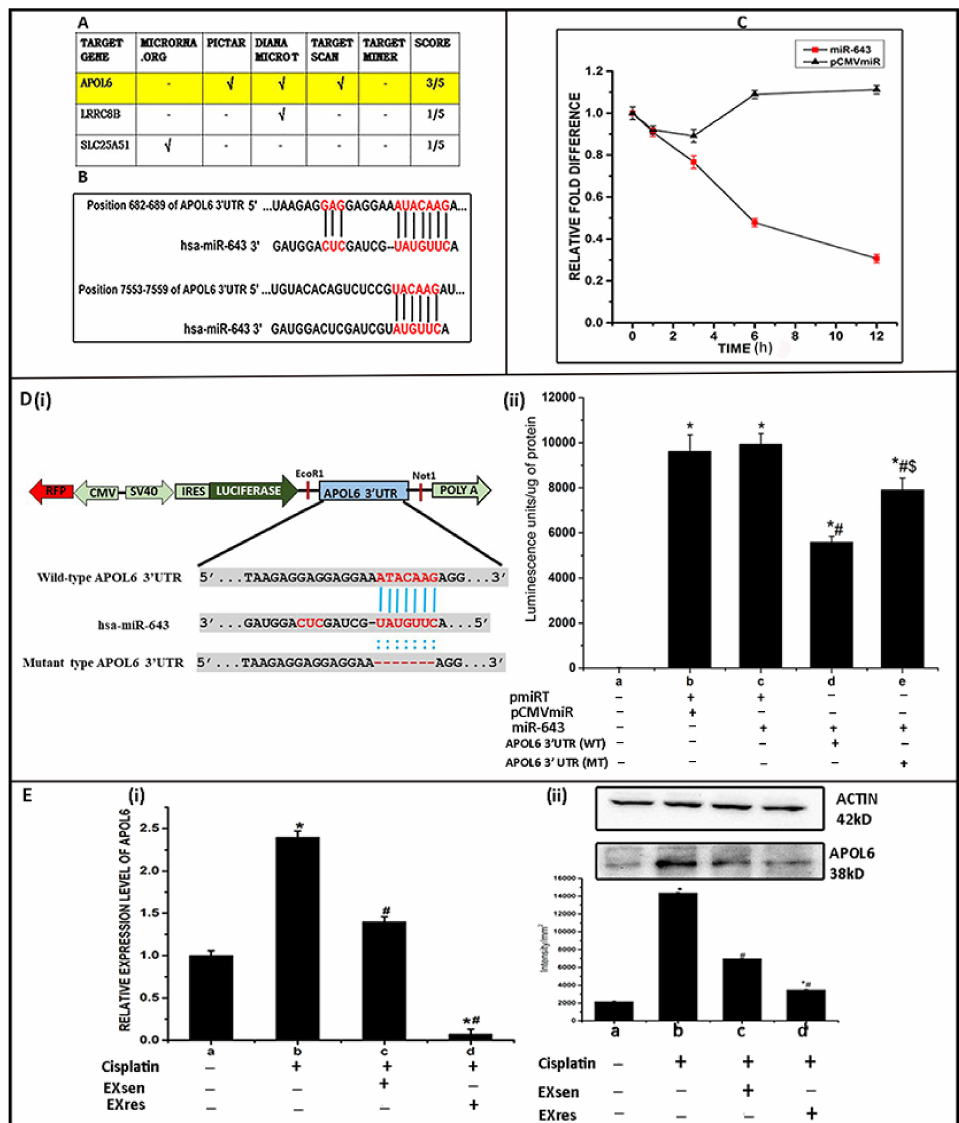
Figure 5. EXres-mediated alteration in cisplatin resistance involves APOL6. ( A ) Target prediction analysis of miR-643. Target prediction analysis of miR-643 was carried out using five different web-based tools such as microrna.org, Pictar, Diana micro T, TargetScan, and Target miner followed by scoring. ( B ) 3 (cid:48) UTR analysis of APOL6 was carried out using a web-based tool TargetScan showing the sequence alignments between miR-643 and 3 (cid:48) UTR of APOL6. ( C ) APOL6 mRNA stability assay. miR-643 overexpressing cells were treated with actinomycin at a concentration of 6 µ g for different time intervals such as 0, 1, 3, 6, and 12 h followed by RNA isolation from these cells and RT-PCR analysis of APOL6 mRNA. The term relative fold difference refers to relative expression level of APOL6 mRNA in the presence or absence of miR-643. ( D ) Luciferase reporter assay. The wild and mutant APOL6 3 (cid:48) UTR were cloned into pMIRTARGET reporter vector downstream of luciferase followed by luciferase activity assay. ( i ) Schematic representation of the modified luciferase vector containing 3 (cid:48) UTR of the APOL6 gene and sequence comparison among APOL6 wild-type 3 (cid:48) UTR, APOL6 mutant-type 3 (cid:48) UTR, and miR-643. ( ii ) APOL6 3 (cid:48) UTR luciferase assay results in Lum/ µ g of protein ( E ). EXres can modulate APOL6 mRNA and protein levels. APOL6 mRNA and protein levels were checked in Hela cells treated with EXsen/EXres and cisplatin. ( i ) qRT-PCR analysis of APOL6 mRNA. ( ii ) Levels of APOL6 protein analysed by Western blot. In ( i,ii ) a—untreated cells b—cells + cisplatin, c—cells + EXsen and cisplatin and d—cells + EXres and cisplatin. The mean values of two different experiments ± SEM each performed in triplicate are reported in the graph, p < 0.05. * indicates statistical significance when compared to a. # indicates statistical significance when compared to b. *# indicates statistical significance when compared to b and c. *#$ indicates statistical significance when compared to b, c and